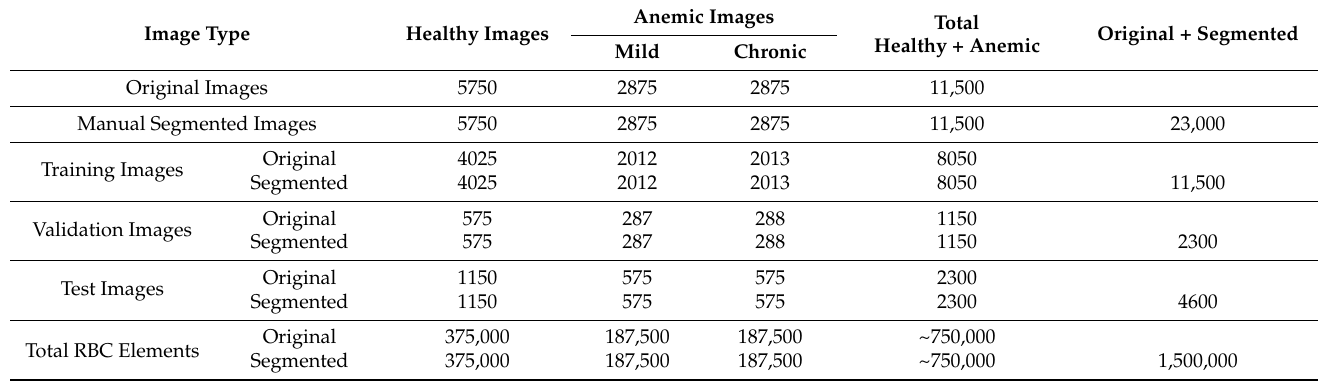
Table 2. Detailed description of original and segmented images used during the training, validation, and testing of the proposed